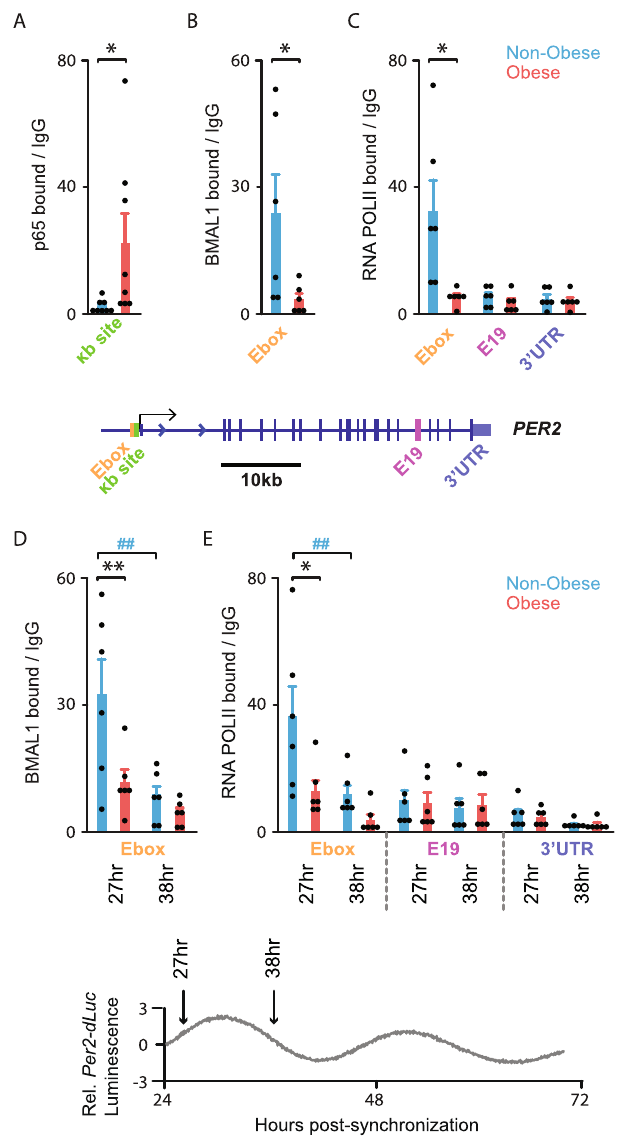
Fig. 2 NF- κ B p65 activation in human obesity results in decreased BMAL1-mediated transcription of PER2 . ChIP analyses of NF- κ B p65, BMAL1, and RNA POLII on PER2 sites in OAPs, as indicated. Cells were either non-synchronized ( A – C ) or harvested 27 h and 38 h post- synchronization ( D , E ). A p65 bound to PER2 κ B site in the promoter